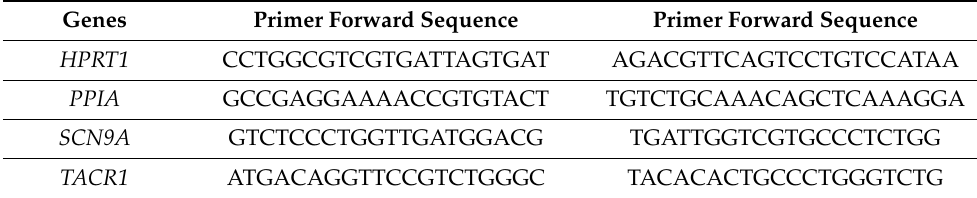
Table 1. Sequences of forward and reverse